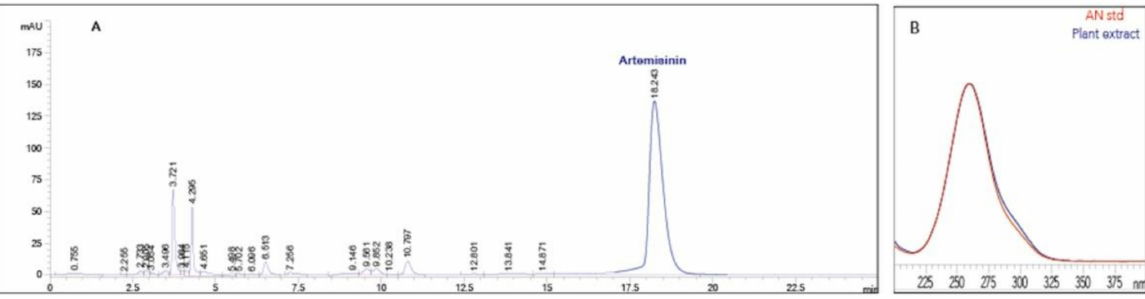
Figure 2. Artemisinin analysis of Artemisia annua regenerated plants (RPs). HPLC chromatogram of plant extracts. The putative artemisinin peak ( A ) was confirmed by comparing spectra of the standard artemisinin with the putative artemisinin peak ( B